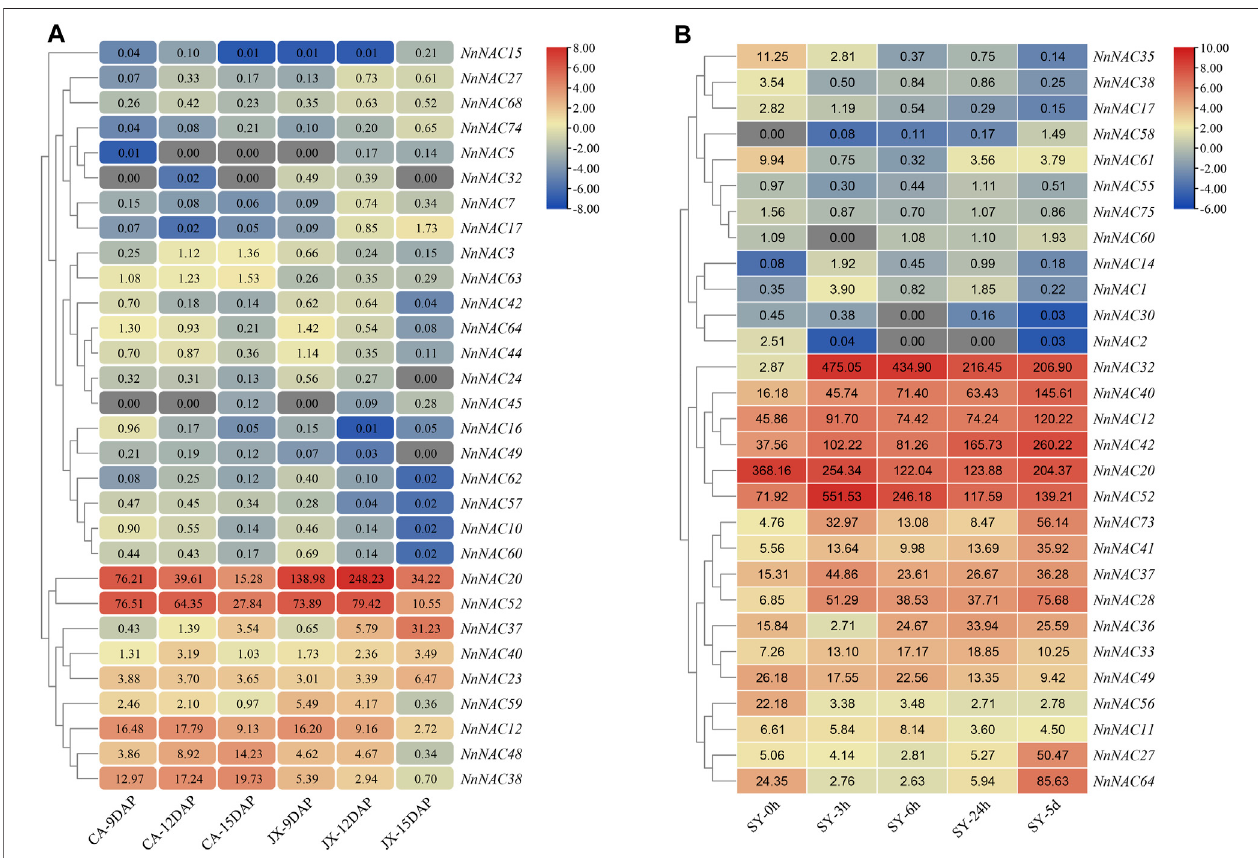
FIGURE6| Expression analysisof NnNAC genesduring lotusseed developmentand response tocomplete submergence. (A) Heat-map showingthe expression patternsof30 NnNAC genesinvolvedinthelotusseeddevelopment(FPKMvalues). (B) Heat-mapshowingtheexpressionpatternsof29completesubmergencestress responsive NnNAC genes in lotus (FPKM values). “ SY ” represent complete submergence stress treatment.